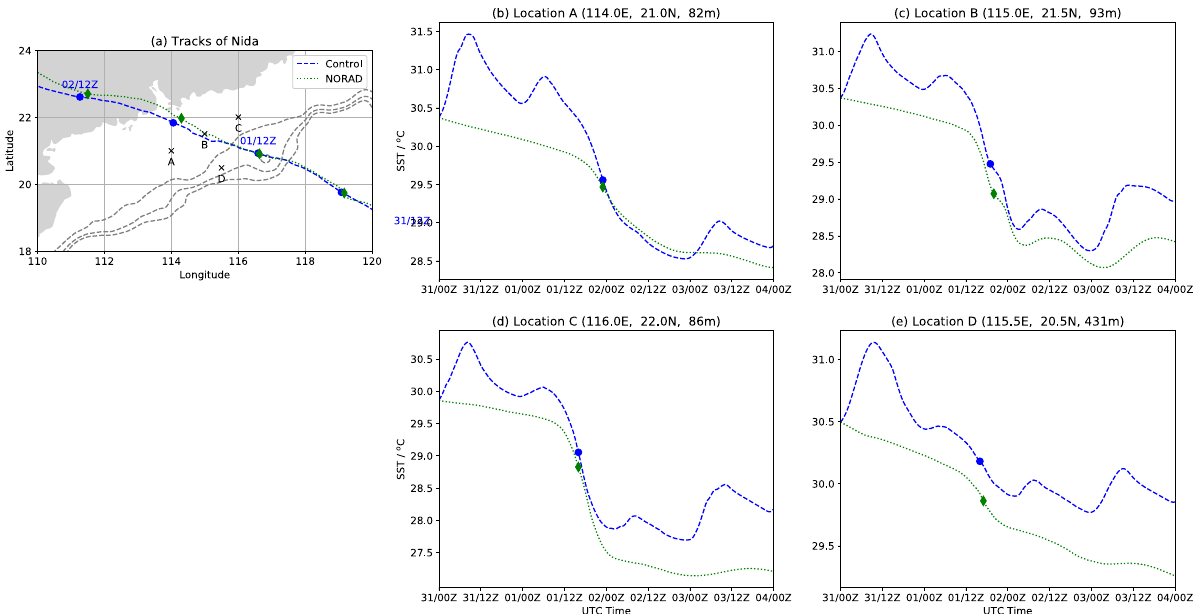
Fig. 7 Time series of SST during the passage of Typhoon Nida. a Simulated tracks of Typhoon Nida with makers at every 12 h, black crosses at the locations of the time series, and ocean isobaths of 200, 600, and 1000 m in gray dashes. b – e Time series of SST at the four locations crossed in a along the edge of continental shelf during the passage of Typhoon Nida in the control (blue dashed) and NORAD (green dotted) experiments. Markers indicate Typhoon Nida ’ s closest time of approach.